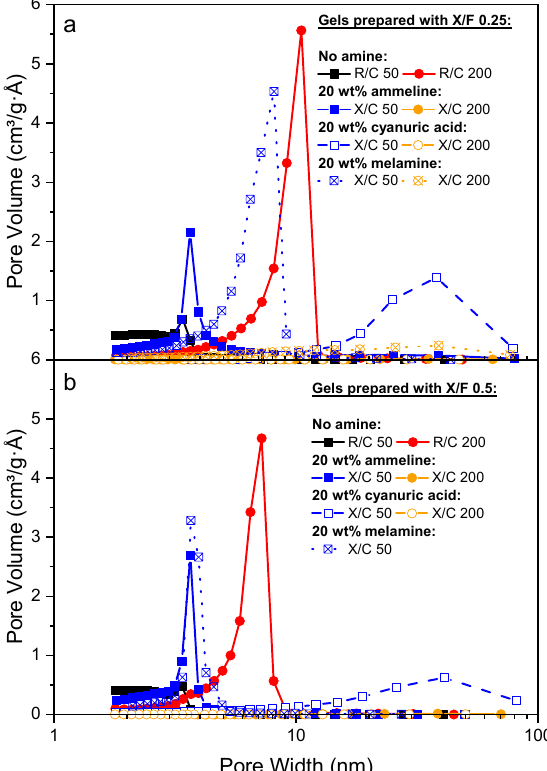
Figure 10. Pore size distributions for gels prepared with 20 wt% of additives with ( a ) X/F 0.25 and ( b ) X/F 0.5.